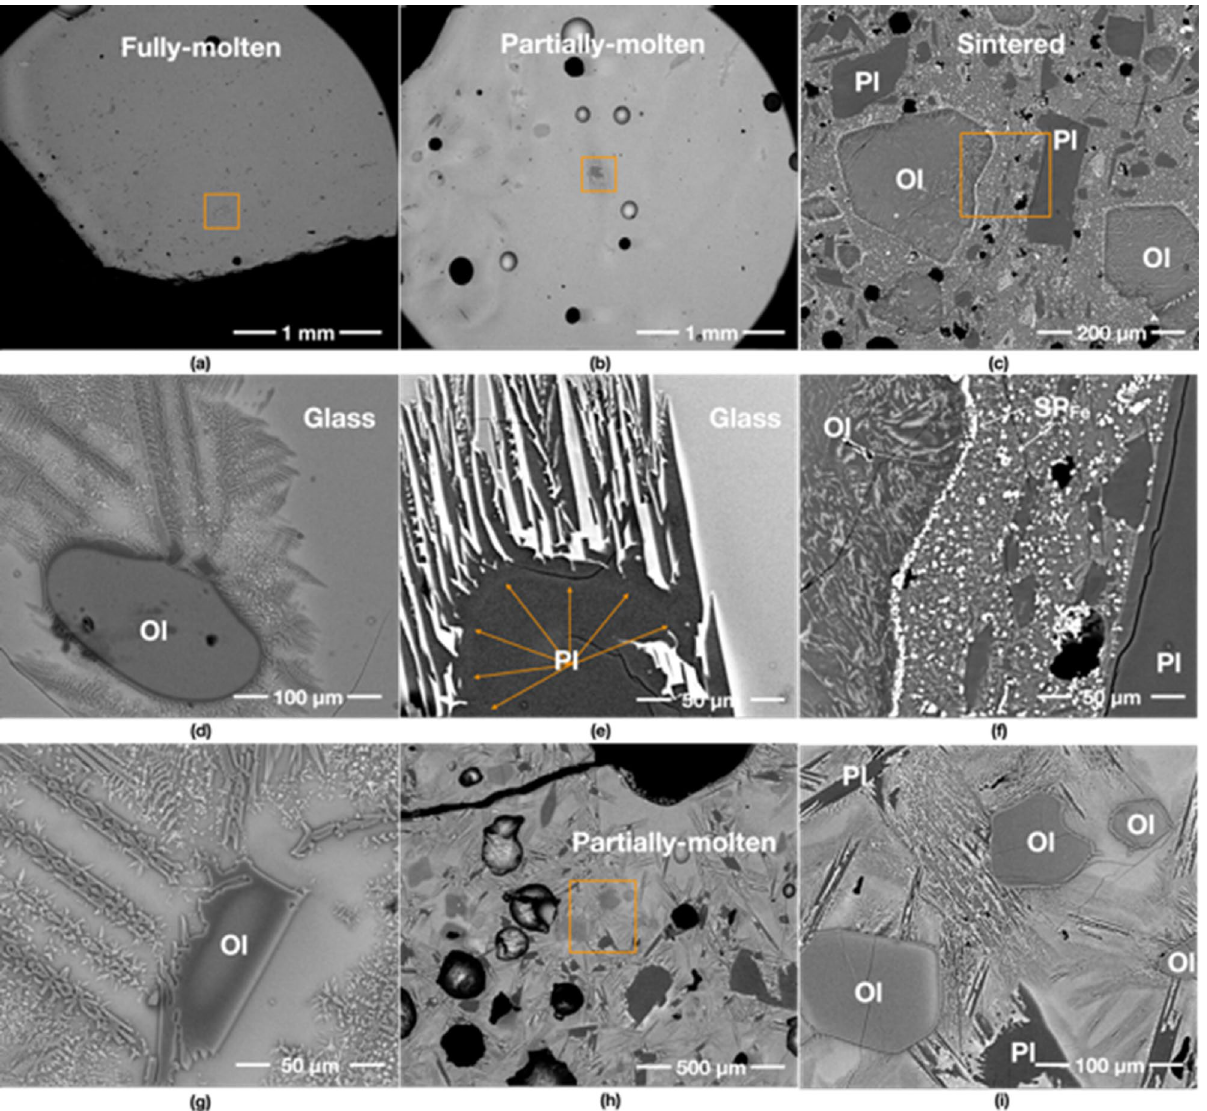
Figure 3. BSE images of the 800 W specimen. ( a – c ) show an overview of its fully-molten, partially-molten and sintered areas, respectively. ( e ) is the detail of the box in ( b ) showing the crystallisation of a plagioclase (Pl) grain with acicular projections, which is new growth upon crystallisation in the surrounding glass. As the grain did not fully melt, the core of the original grain is still preserved. ( f ) is the detail of the box in ( c ) depicting formed Fe-rich spinel (SP Fe ) particles from an olivine grain and the glass matrix. ( d , g ) show the neo-crystallisation of olivine from the melt. Unlike ( d ), the olivine in ( g ) has a second light-coloured rim with a very angular shape indicative of new crystallisation during cooling. ( i ) is the detail of the box in ( h ), indicating that minerals are starting to melt in the partially molten crucible surface instead of the specimen surface (see “Methods” section), and the hotspot of each specimen occurred outside the pyrometer focus. Moreover, the specimens were surrounded by a ceramic paper to prevent thermal shock to the alumina crucible, which results in significant thermal insulation. Thus, the recorded tem- peratures shown in Fig. 7a are much lower than what the specimens experienced. With a separate experiment directly measuring the hotspot position on the crucible surface, the temperature was over 1200 °C, which is reasonable as the temperature of the hotspot caused by thermal runaway is around 1700–2200 °C 14 considering the heat absorption of the crucible and ceramic paper. As expected, the graph shows that higher input powers reached higher peak temperatures in a shorter time, whereas the peak temperatures for lower input powers were reached more slowly. All five specimens experienced thermal runaway with bright hotspots on the crucible surface (see the solid symbols in Fig. 7a). Regardless of the absolute temperatures in each case, it is interesting to note that the temperature curves of the five specimens represent a consistent heating trend, including thermal runaway, which results in a radical temperature increase. Figure 7a also shows a flattening of the temperature curves towards the end of their heating cycles, possibly caused by a higher radiative heat loss than heat absorption. This is notably affecting the 400 W and 250 W